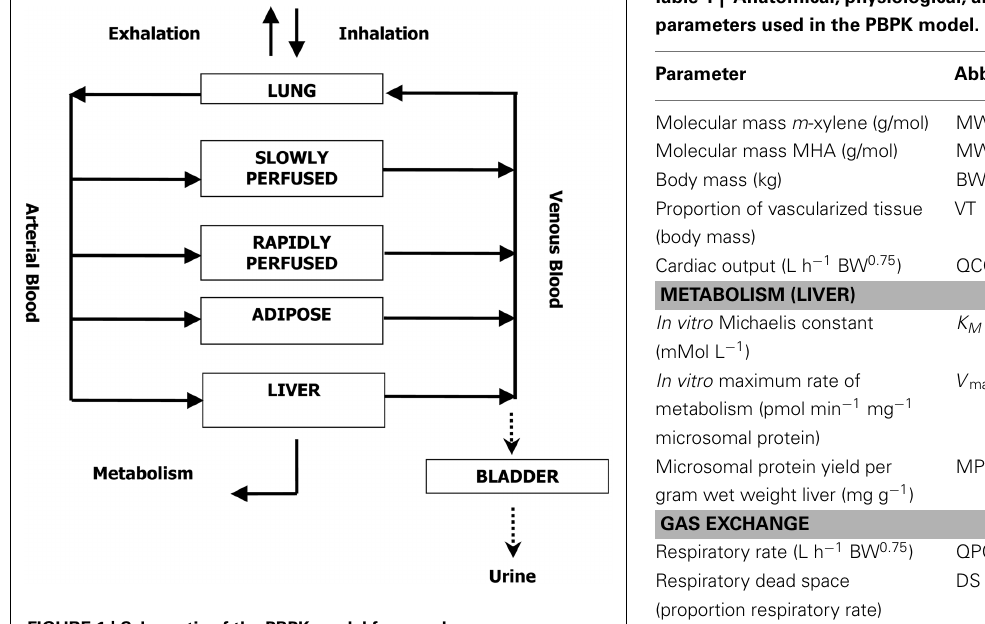
FIGURE 1 | Schematic of the PBPK model for m -xylene.